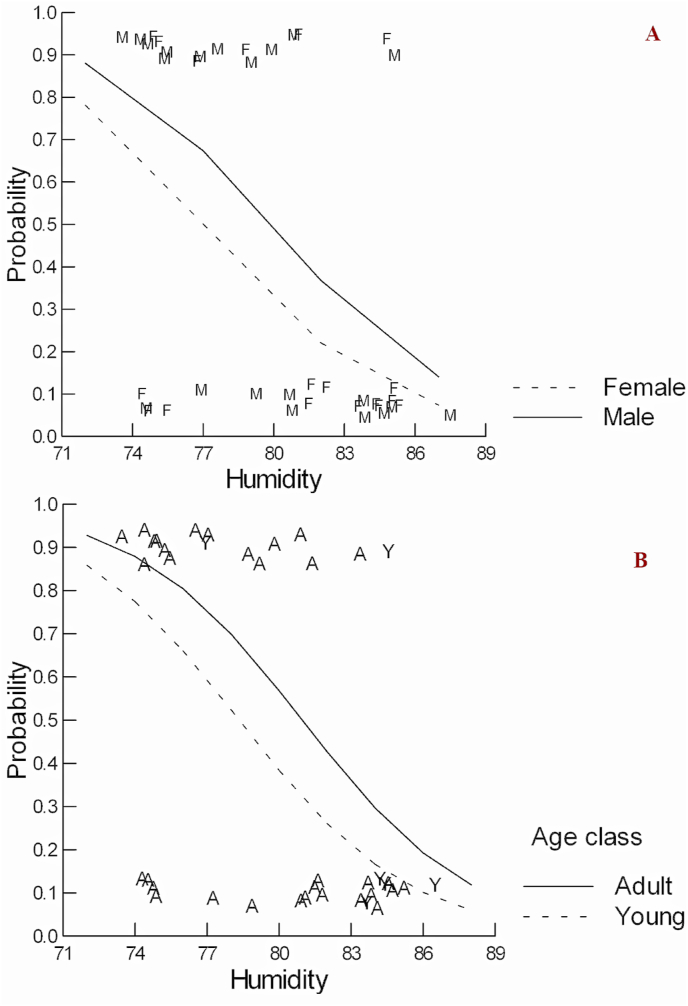
Probability of lice occurrence on Trinomys iheringi as a function of humidity and sex (A), and humidity and age class (B) in Ilha Grande State Park, RJ, Brazil. The letters in the upper part of the graph represent the presence of lice on rodents, and the letters in the lower part of the graph indicate the absence of lice on rodents.